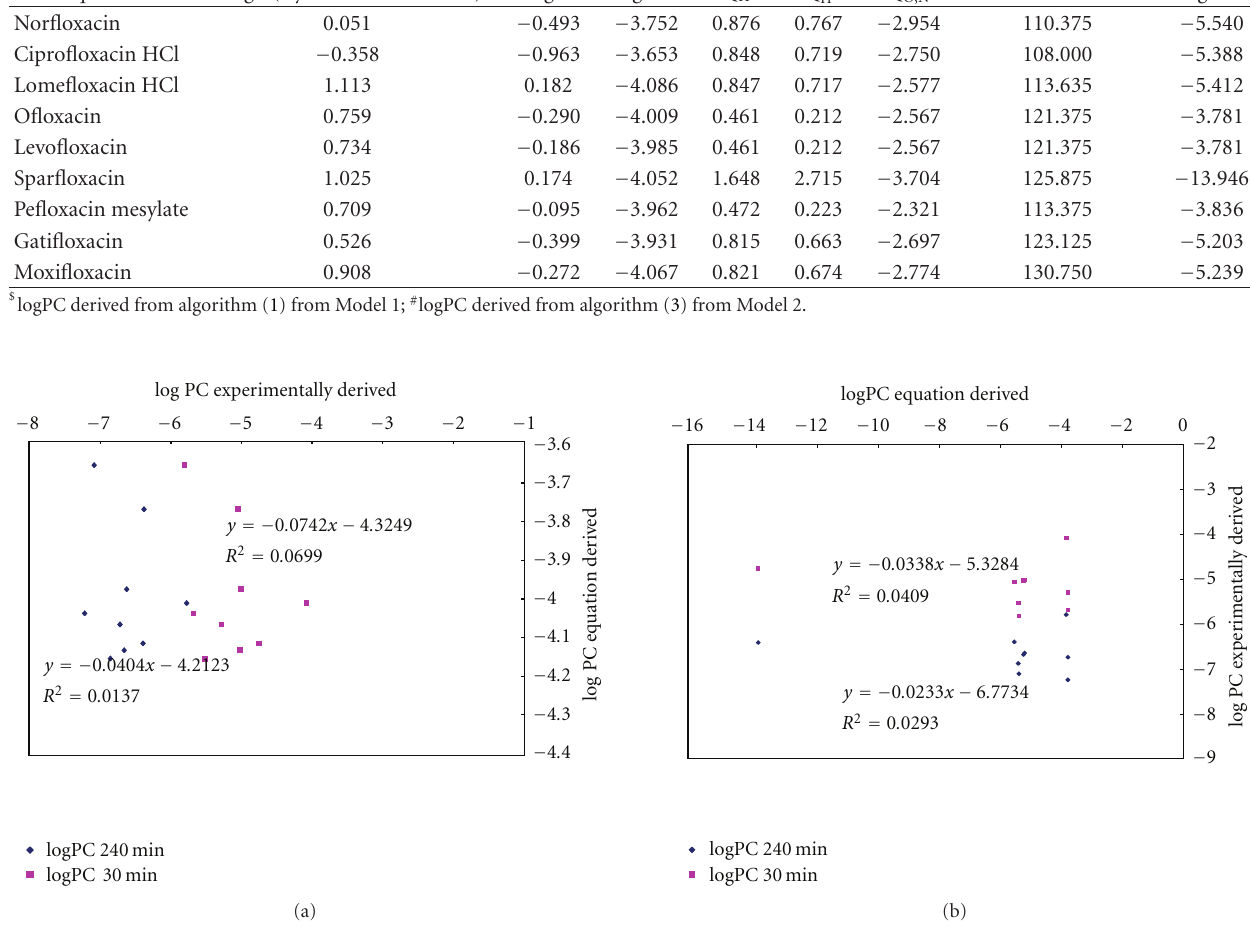
Figure 3: (a) Permeability coe ffi cient (logPC) derived using algorithm (1) versus permeability coe ffi cient (logPC) derived from in vivo study. (b) Graph between permeability coe ffi cient (logPC) derived using algorithm (3) versus permeability coe ffi cient (logPC) derived from in vivo study.